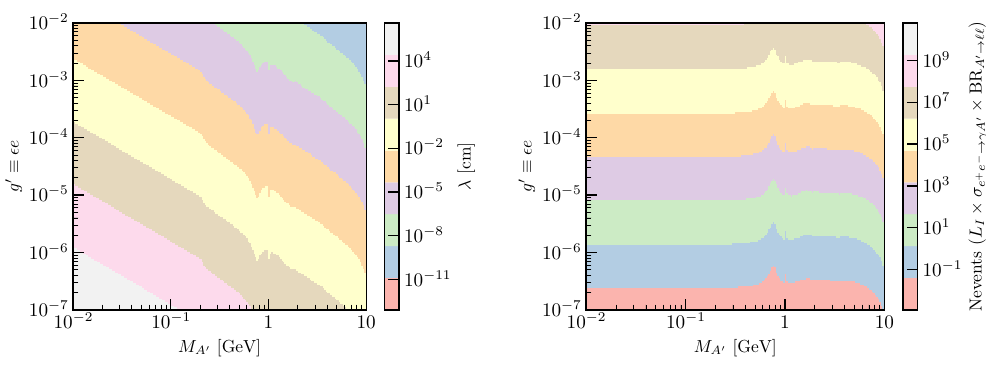
Figure 4 . Left: the characteristic length of decay, λ , for different values of M A 0 and g 0 ( ≡ (cid:15)e ) . The shades indicate different ranges for λ , as given by the colorbar to the right. Right: we plot the number of events produced at 50 ab -1 of luminosity for different values of M A 0 and g 0 . The shades indicate different ranges for the number of events produced, as given by the colorbar to the